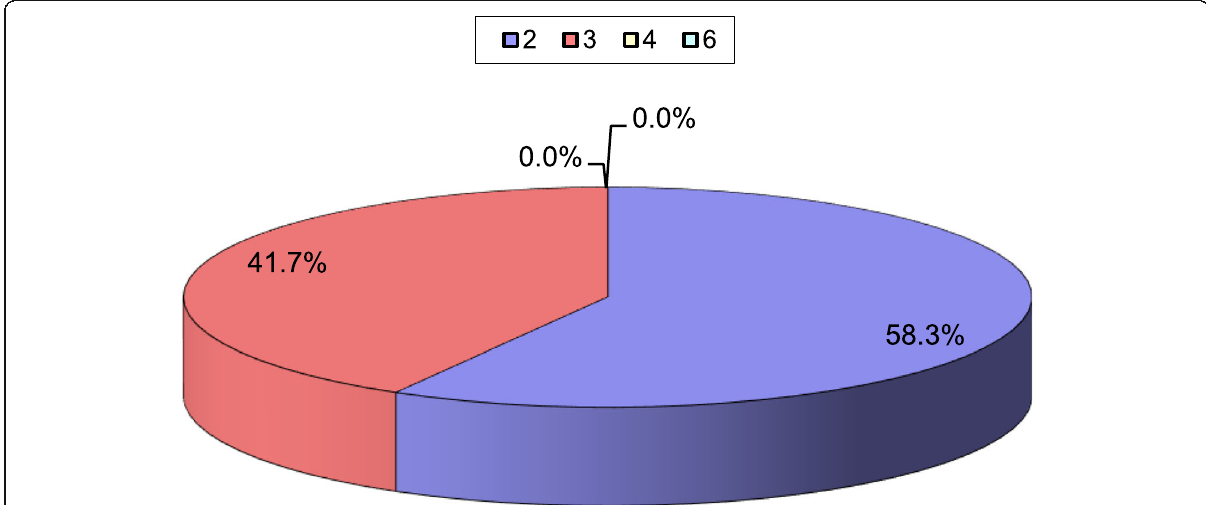
Fig. 5 The Sedation scores at 45 min after dexmedetomidine